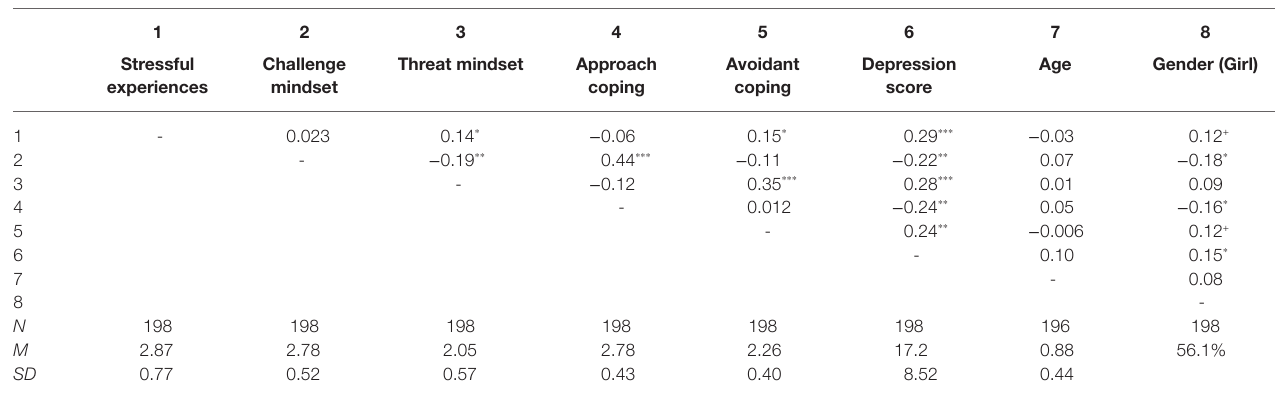
TABLE 2 | Correlations among the main variables in migrant